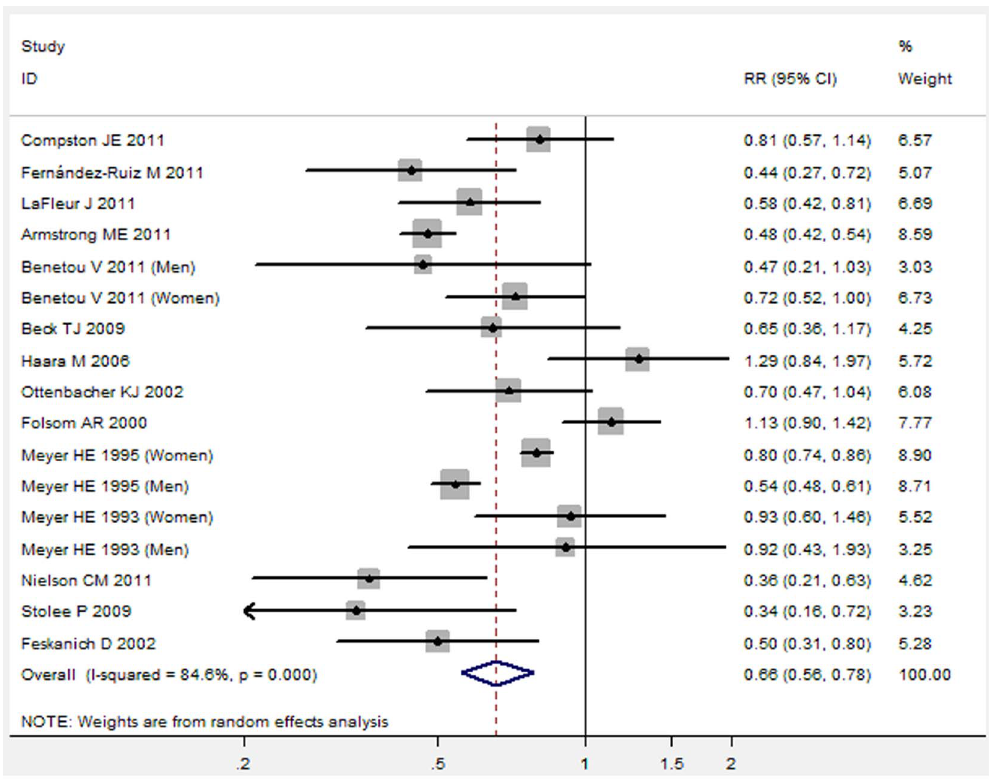
Figure 3. Forest plot showed an association between adult obesity and decreased risk of hip fracture (Analysis of unadjusted RRs).